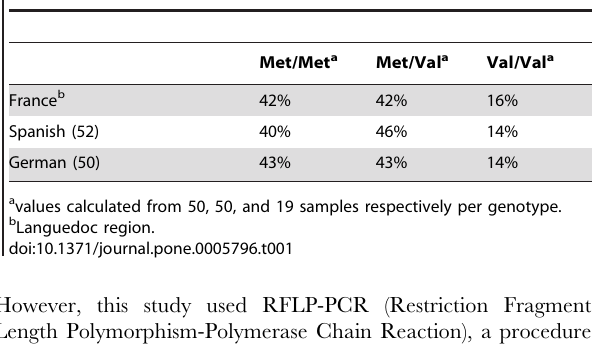
Table 1. M129V polymorphism distribution.